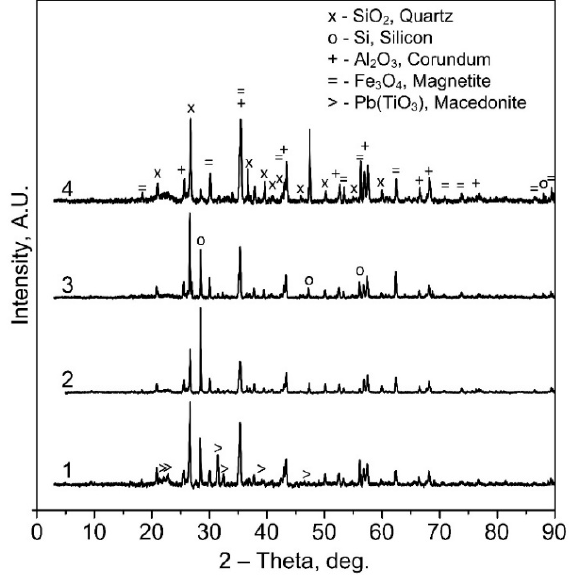
Figure 14. XRD patterns of solid residues from the experiments at different experiment durations: 1–0.5 h, 2–2 h, 3–4 h and 4–5 h. Other experimental conditions are provided in the caption of Figure 13.